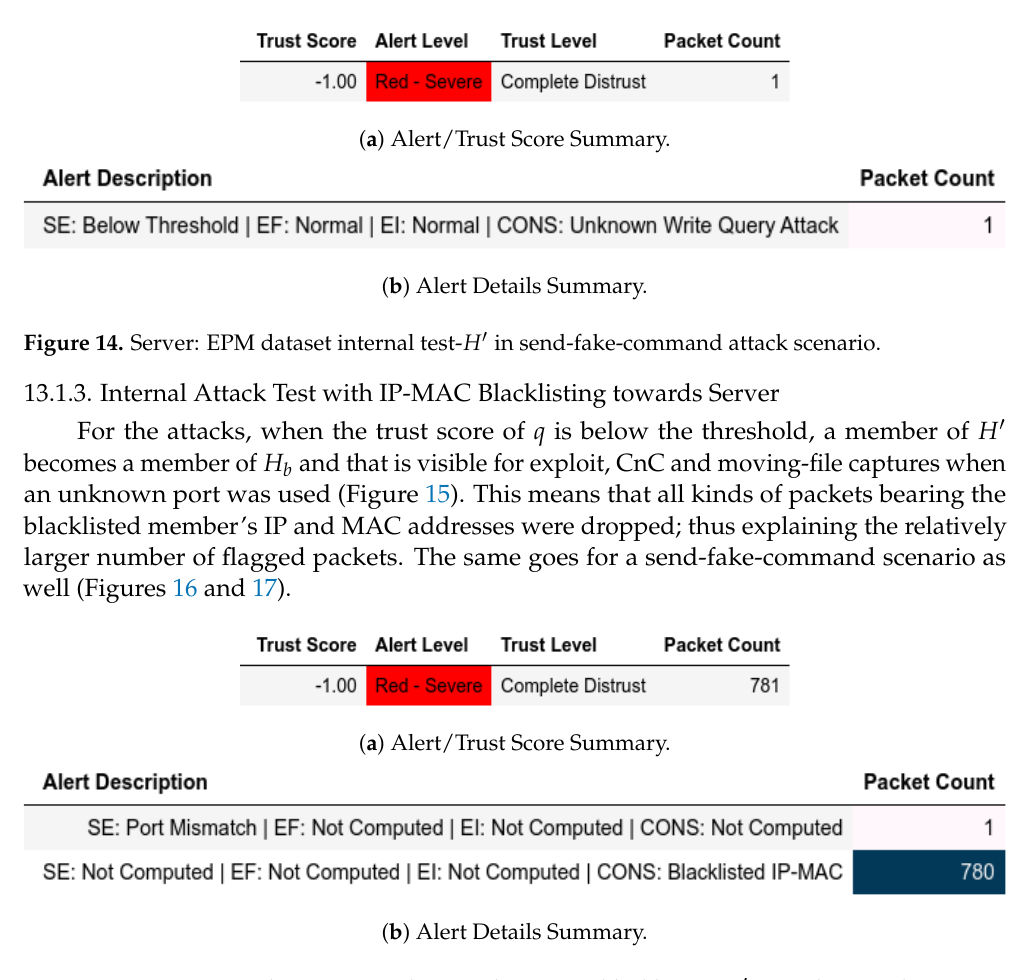
Figure 15. Server: EPM dataset internal test with IP-MAC blacklisting- H (cid:48) in exploit attack capture.